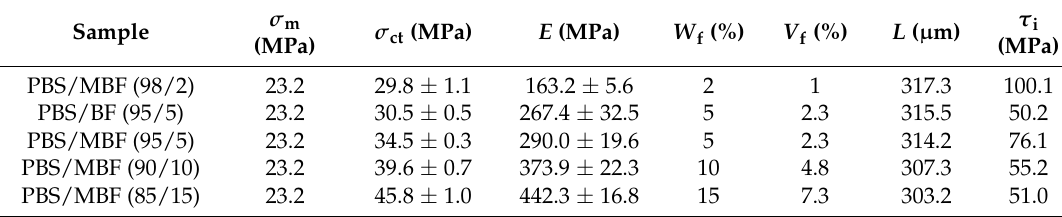
Table 2. IFSS of PBS/BF and PBS/MBF composites.